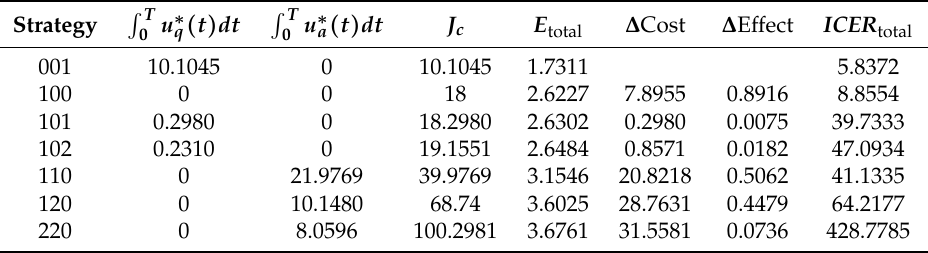
Table 7. ICER calculation for strategies fulfilling the ascendant order for costs J c and combined effects E total accounting for environmental impact and reduction of the mosquito population.